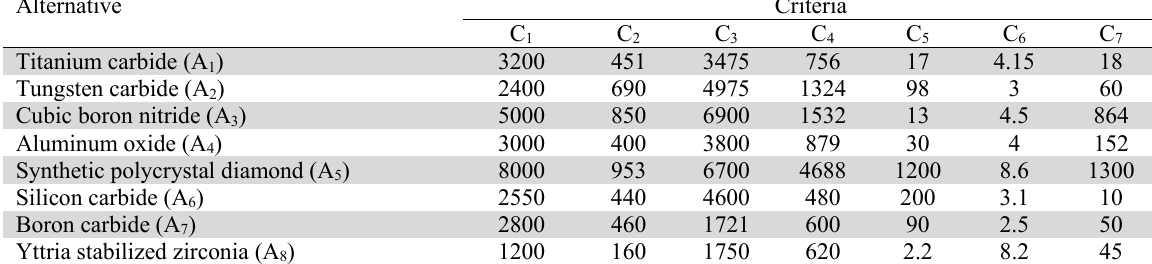
Decision matrix for grinding wheel abrasive material selection problem (Maity & Chakraborty, 2013)